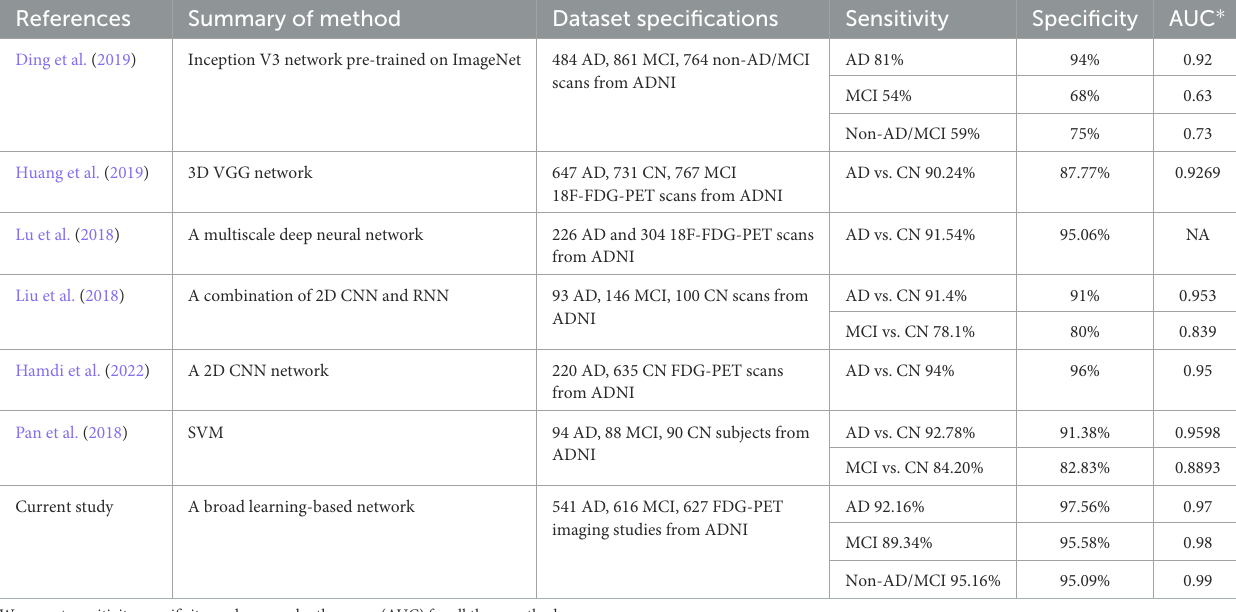
TABLE 4 Summary of state-of-the-art methods for prediction of Alzheimer’s disease (AD) using 18F-FDG-PET imaging.